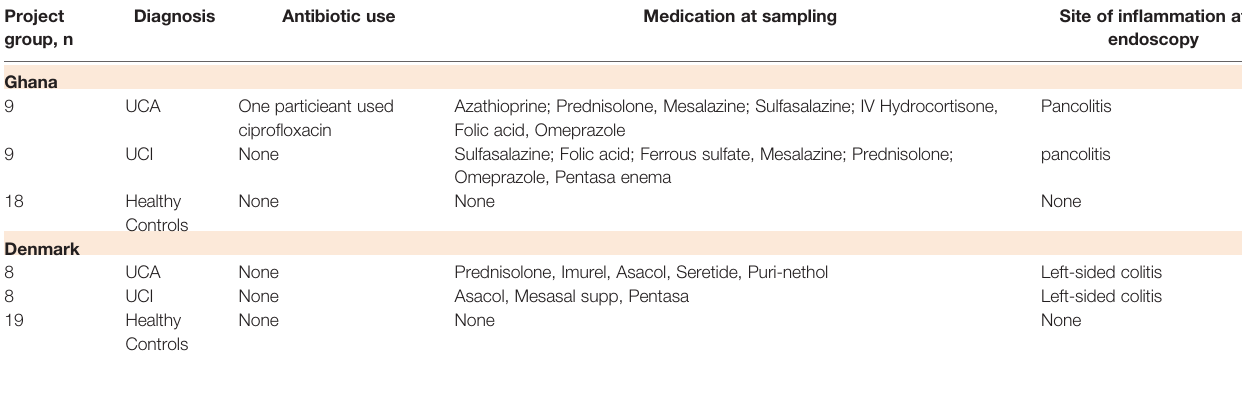
TABLE 1 | Number of the participants in the study groups, clinical data, medicine and antibiotic use. Project group,